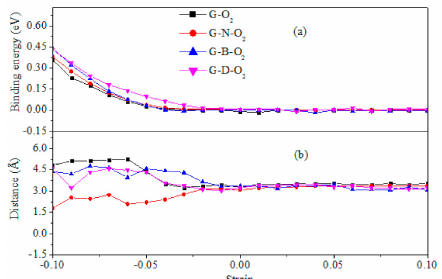
Figure 2. ( a ) Binding energy (E b ) per atom as a function of equibiaxial strain for G–O 2 , G–N–O 2 , G–B–O 2 , and G–D–O 2 ; ( b ) The shortest distance of the O atom to di ff erent graphenes with equibiaxial strain..